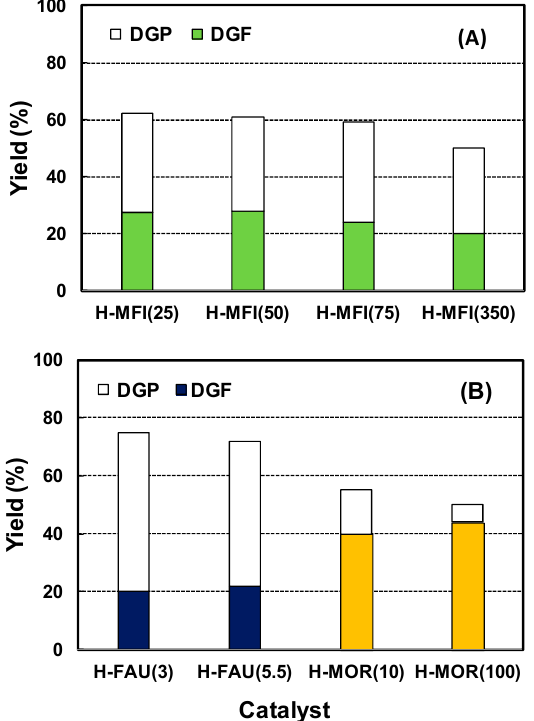
Figure 7. Yields of decyl glucosides on various zeolite catalysts with different Si/Al molar ratios in the direct glucosidation reaction catalysts at 130 °C after a process time of 4 h. ( A ) H ‐ MFI zeolites, ( B ) H ‐ FAU and H ‐ MOR zeolites.